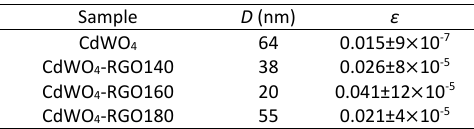
Table 1. Calculated average crystallite size and lattice mi - crostrain for the samples.